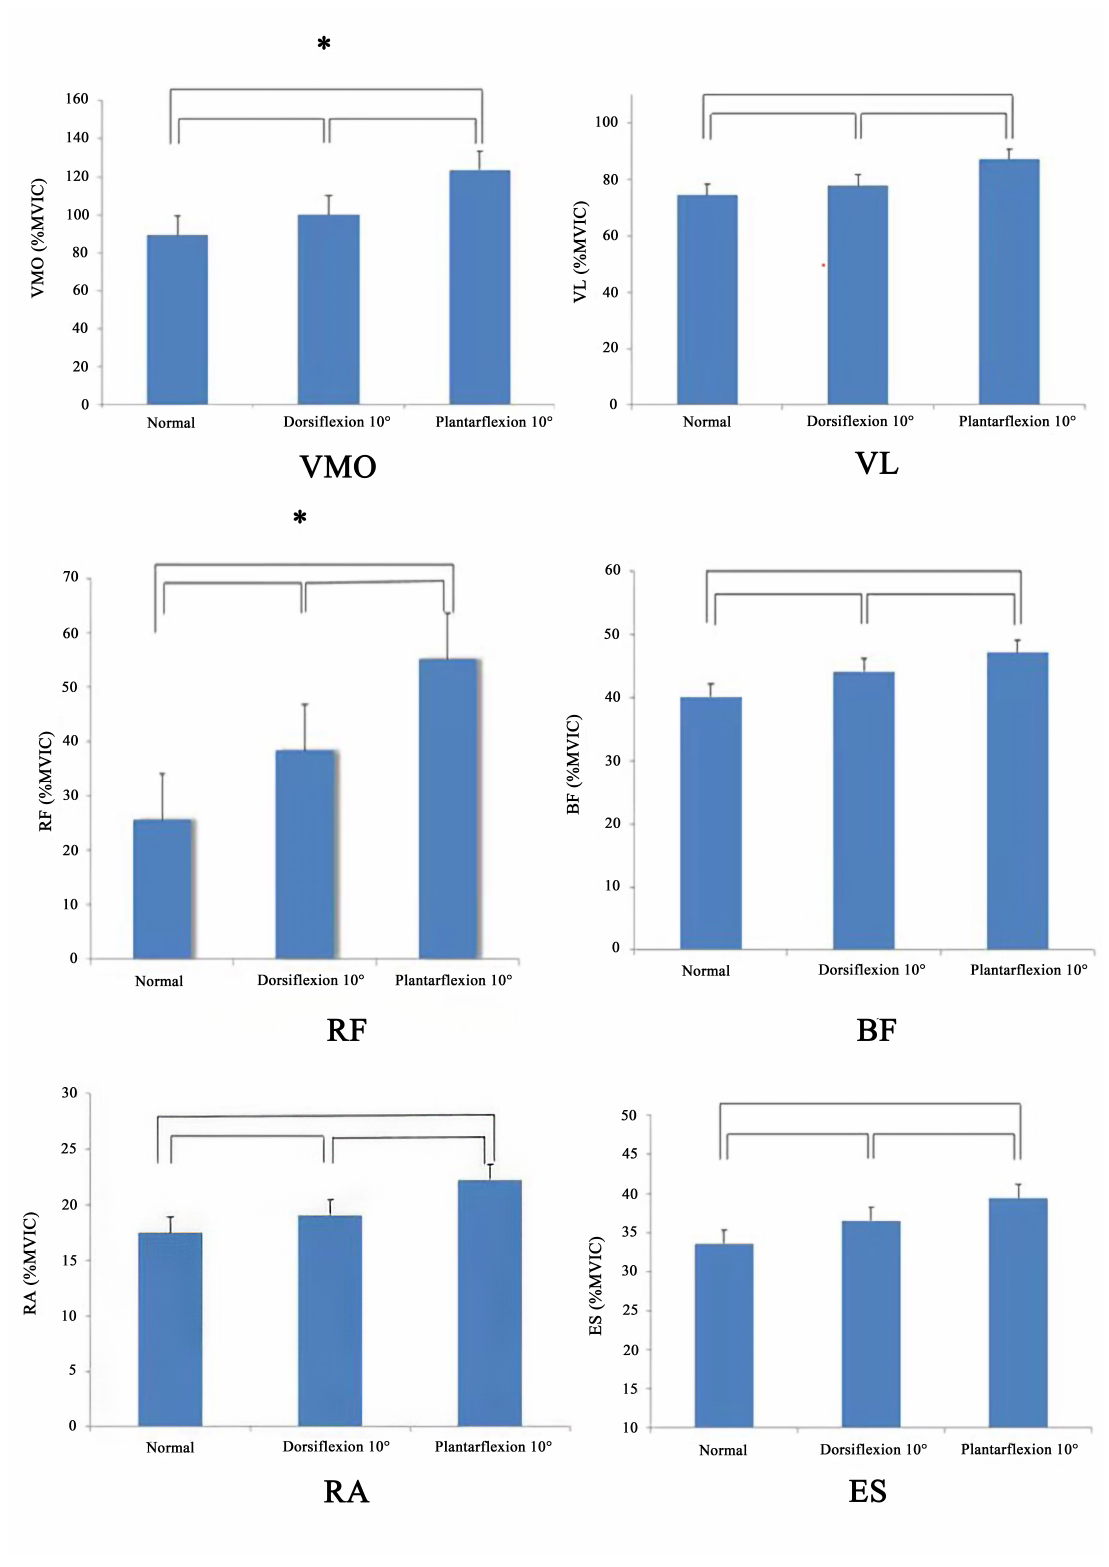
Fig. 4. Comparison of changes in muscle activation according the ankle angle during wall squatting postures. VMO, vastus medialis obliques; VL, vastus lateralis; RF, rectus femoris; BF, biceps femoris; RA, rectus abdominis; ES, erector spinae; * p <